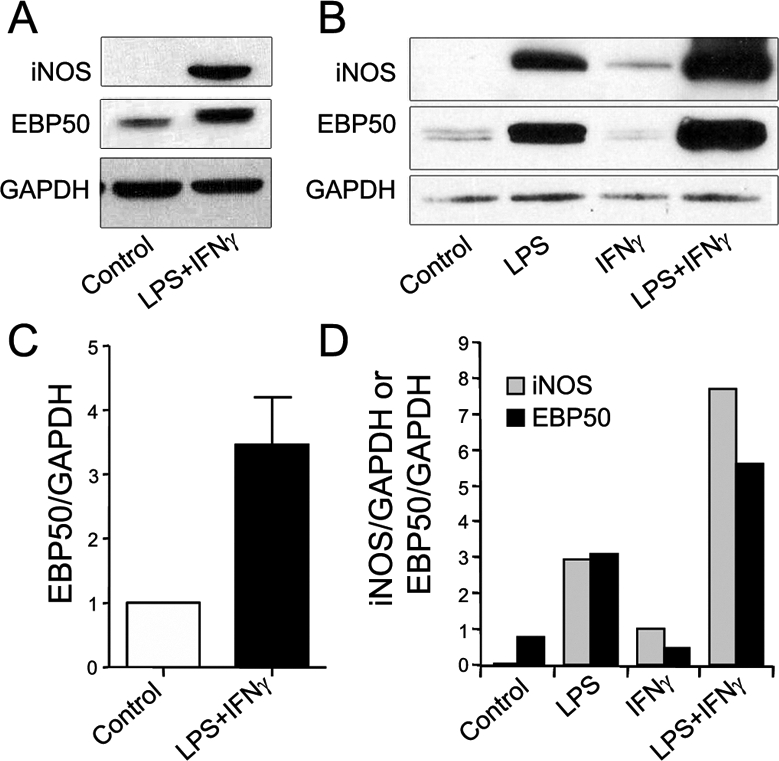
EBP50 Expression Is Increased upon IFN-γ and LPS StimulationMacrophages were stimulated with IFN-γ and LPS or left in media for 16 h, lysed, and analyzed by western blot.(A) Expression of iNOS, EBP50, and loading control (GAPDH) in either media or media with IFN-γ and LPS.(B) Expression of iNOS, EBP50, and loading control (GAPDH) in untreated (control), LPS-treated, IFN-γ-treated, or LPS- + IFN-γ-treated cells.(C) Quantification of increase in EBP50 expression. Bars, mean ± s.e.m (three independent experiments).(D) Quantification of EBP50/GAPDH and iNOS/GAPDH in untreated (control), LPS-treated, IFN-γ-treated, or LPS + IFN-γ-treated cells.